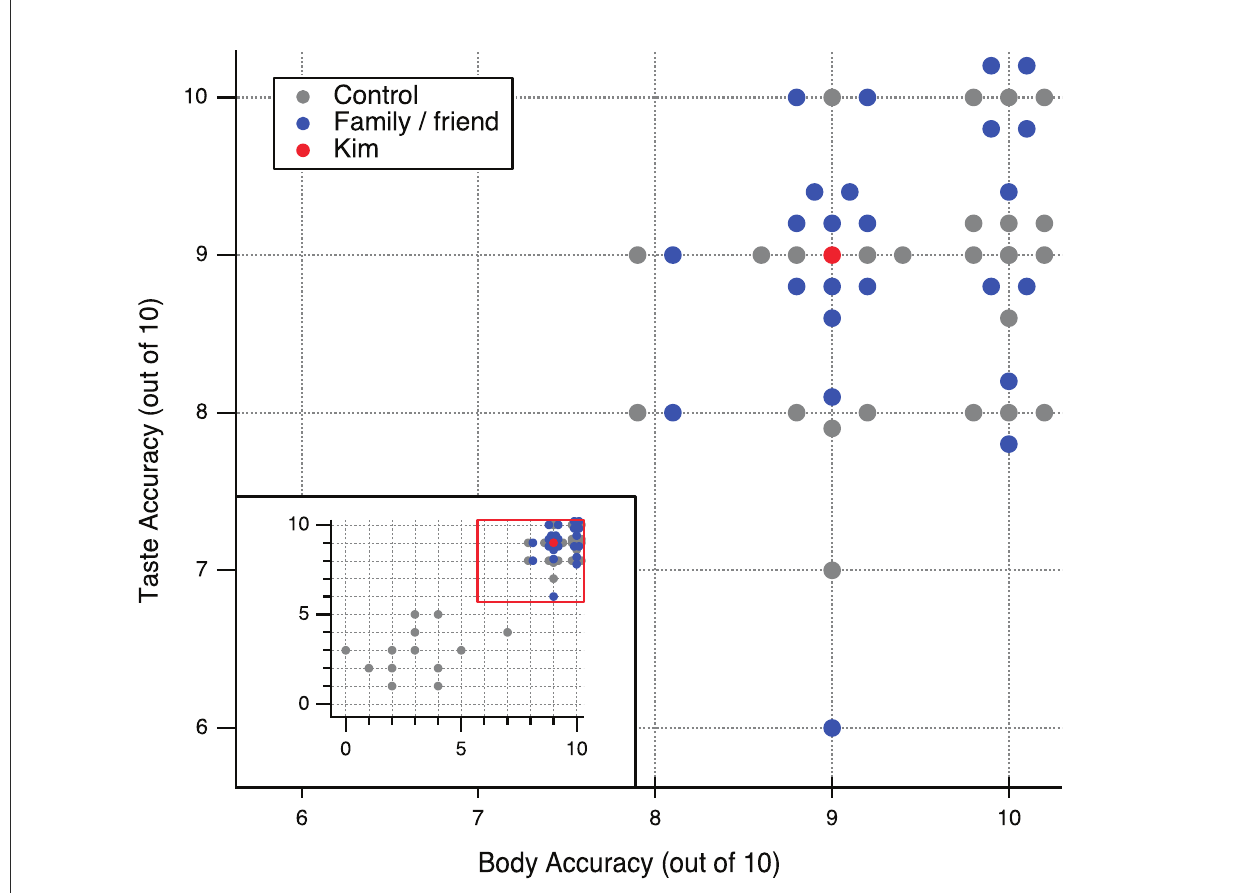
FIGURE2 Number of expressions accurately selected given the context for the body part (x-axis) and taste (y-axis) expressions. The number 10 indicates that the accurate and anticipated expression was selected for every vignette, while 2.5 indicates performing at chance. The inset illustrates accuracy for all participants who passed the attention checks, but the primary pane focuses on the attentive participants performing well above chance. Note that Kim (in red) and all the direct-recruited friends and family of Kim (in blue) are performing near